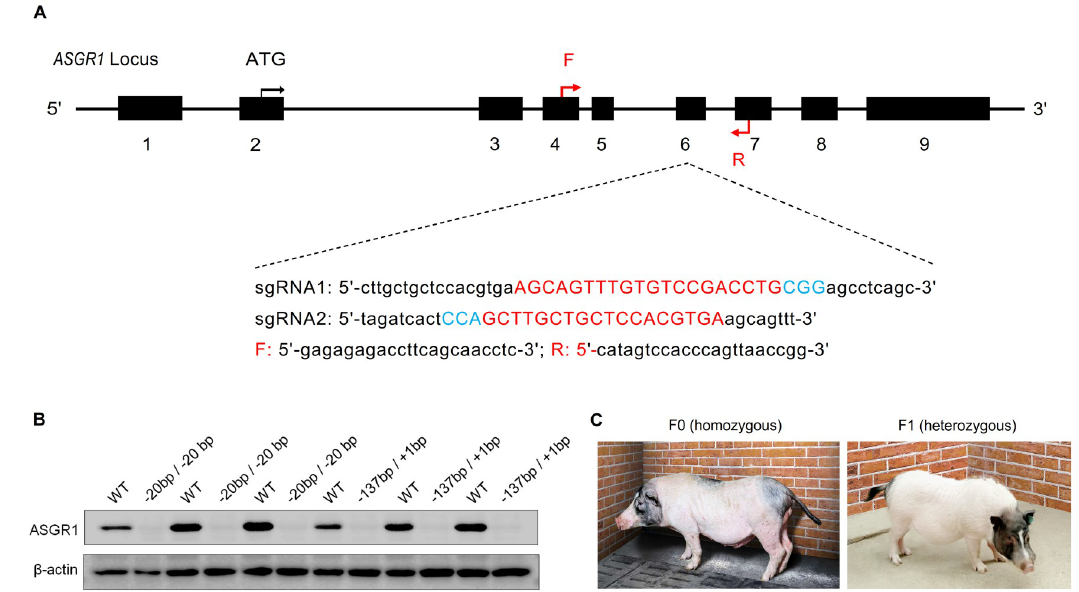
Fig 1. Generation of ASGR1 knockout pigs. A . Schematic diagram of Cas9-sgRNA targeting sites of the pig ASGR1 locus. Two sgRNAs were used to target pig ASGR1 exon 6 to promote DNA breaks and homologous recombination. The sgRNA targeting sequences are shown in red, and the PAM sequences are shown in blue and are underlined. E1-E9: Exon 1–9; the black arrow: Site of the start codon; the red arrow: primer site of the genotyping. B . Western blots of ASGR1 and internal control β -actin in the livers of 24-month-old ASGR1 -/- pigs (the -20 bp / -20 bp and the -137 bp / +1 bp genotypes, n = 3 in each phenotype) and age-matched WT pigs ( n = 6). C . Representative photograph of founder ( ASGR1 -/- ) pigs and F1 ( ASGR1 +/- ) pigs. PAM, protospacer adjacent motif; WT,